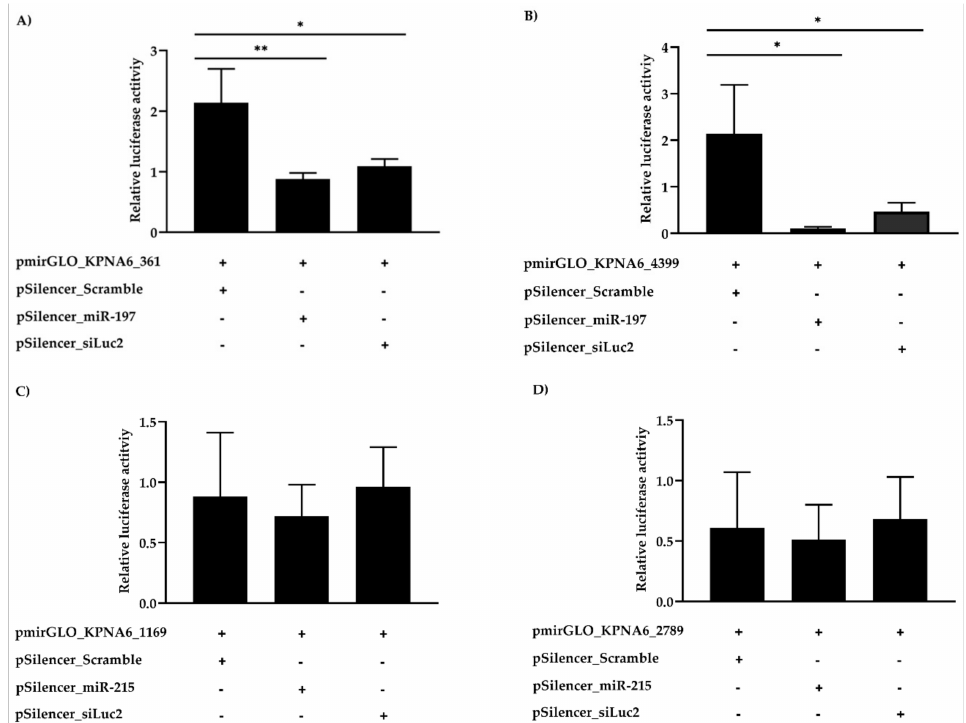
Figure 3. Luciferase activity. The MDCK cells were co-transfected with a reporter vector